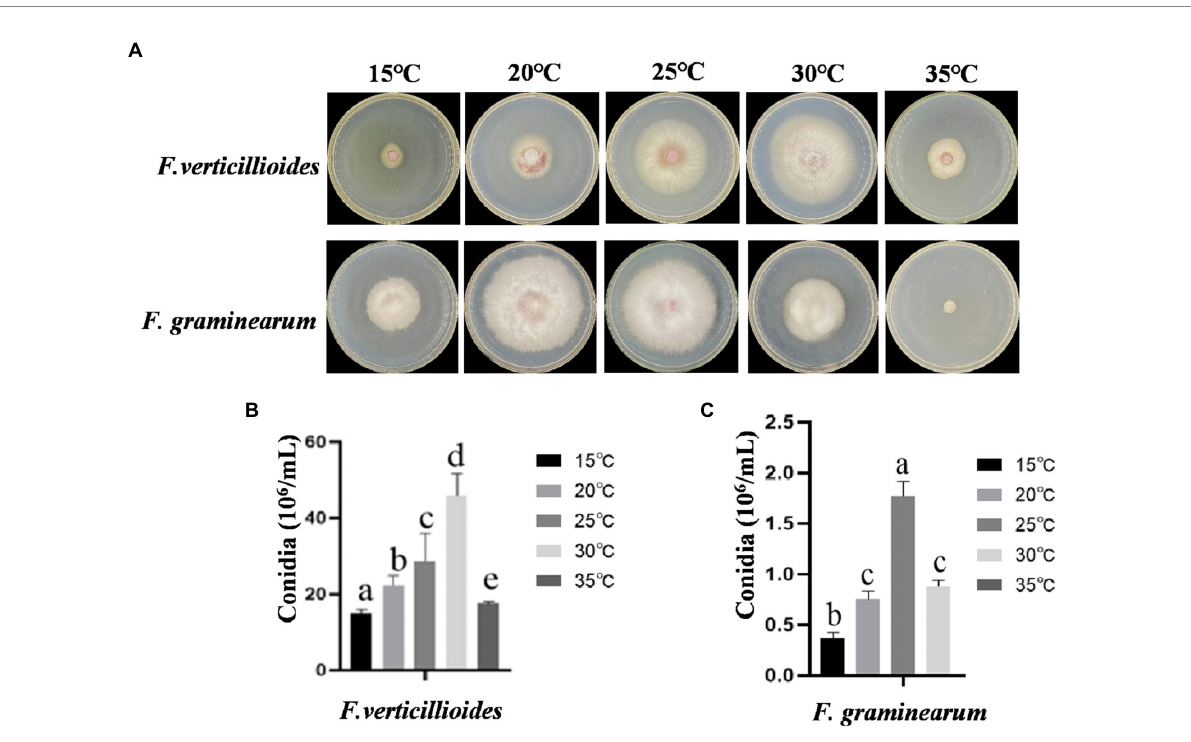
FIGURE 1 The effect of culturing temperatures on growth and conidial production of Fusarium verticillioides and Fusarium graminearum . (A) Growth of F. verticillioides and F. graminearum cultivated at 15–30 ° C. Pictures were taken at 4 days after the initial inoculation. (B) Conidial production of F. verticillioides grown at 15–30 ° C. (C) Conidial production of F. graminearum grown at 15–30 ° C. Values are means, with standard error bars ( n = 3). Columns with non-matching letters indicate a significant difference at p <